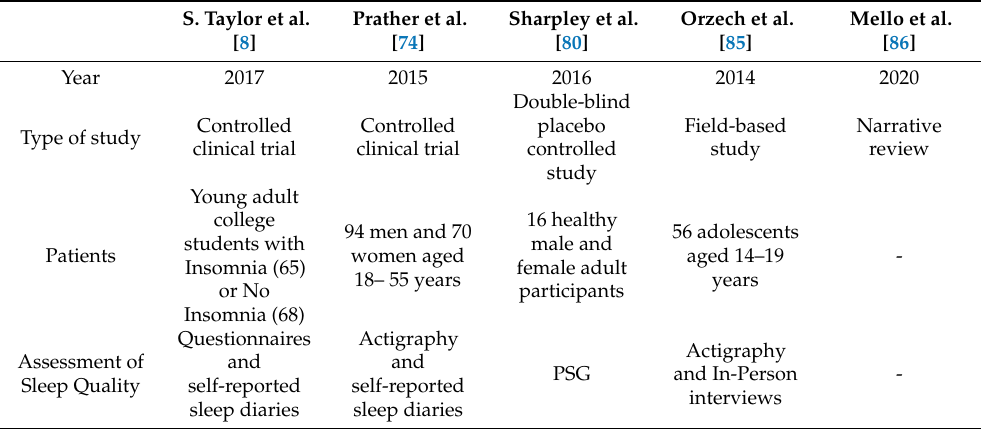
Table 3. Sleep disturbances and their influence on immune memory formation, vaccine effectiveness, and infectious disease